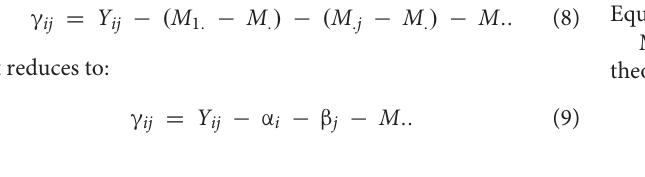
Reciprocal round